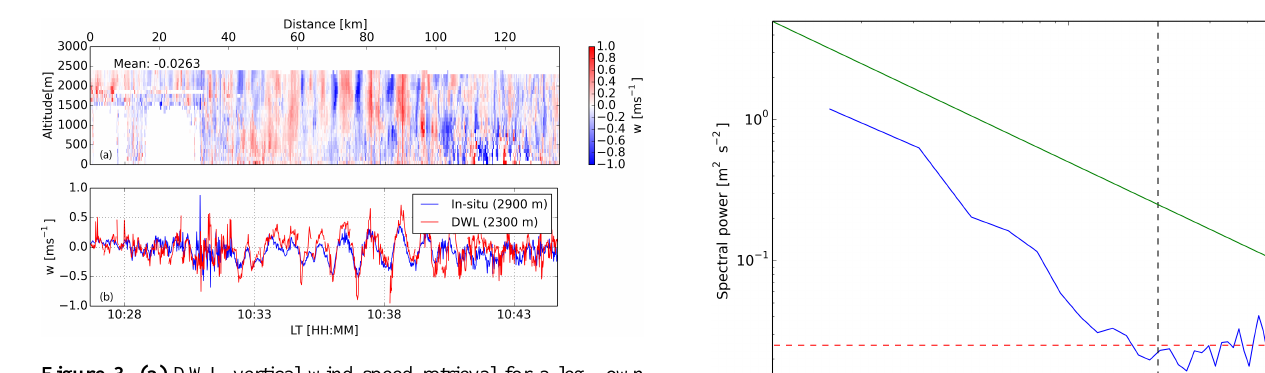
Figure 3. (a) DWL vertical wind speed retrieval for a leg flown on 20 June 13 between 10:31 and 10:45LT. Positive (red) indicates upward winds and negative (blue) indicates downward winds. Be- tween 10:27 and 10:31LT the DWL coverage is limited due to the presence of clouds (white regions below 1500m). (b) Comparison between the vertical wind retrieved by the Falcon 20 (blue) for an altitude of 2900m and the DWL retrieval (red) for an altitude of 2300m.